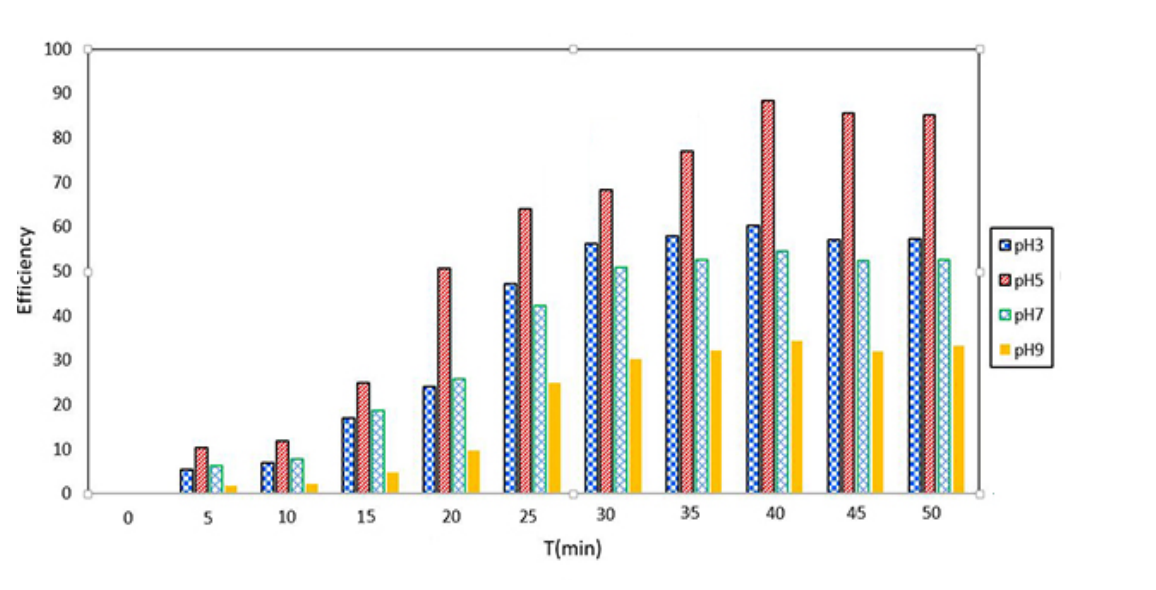
Figure 7. pH effect on removal efficiency of 1-naphthol (pH=5, P<0.05)